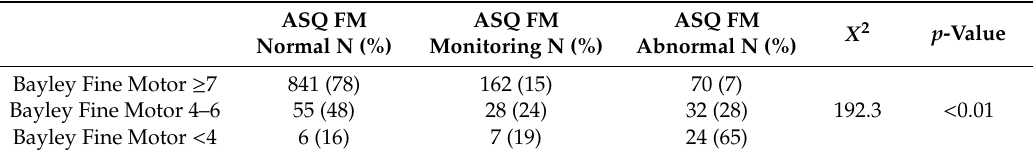
Table 5. Comparison of Bayley-III Fine Motor subscale and ASQ Fine Motor (FM). ASQ